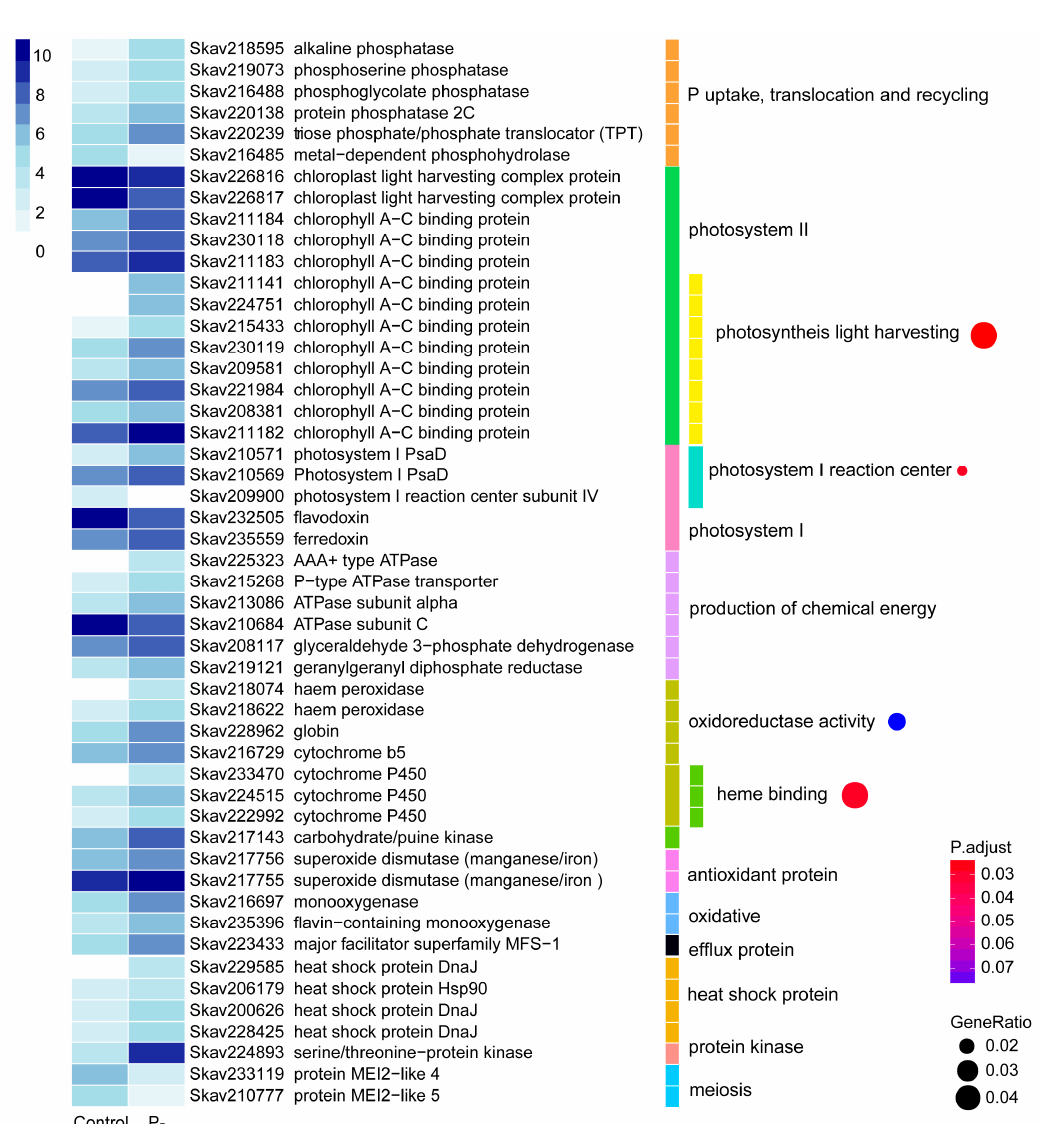
Figure 3. Differential gene expression in response to phosphate deprivation. The heatmap color strength represents log2-transformed gene expression by fragments per kilo-base of exon model per million mapped fragments (FPKM), from dark blue (highest), light blue, to white (lowest). Each color bar on the middle marks a functional category. Each dot on the right marks a category based on GO enrichment ( p -value cutoff = 0.1). The dot size represents enriched DEGs count. The color strength represents the p -value. Control: SymkaSL2 grown in L1 medium at 25 °C. P-: SymkaSL3 was grown in L1 medium with depleted DIP at 25 °C.